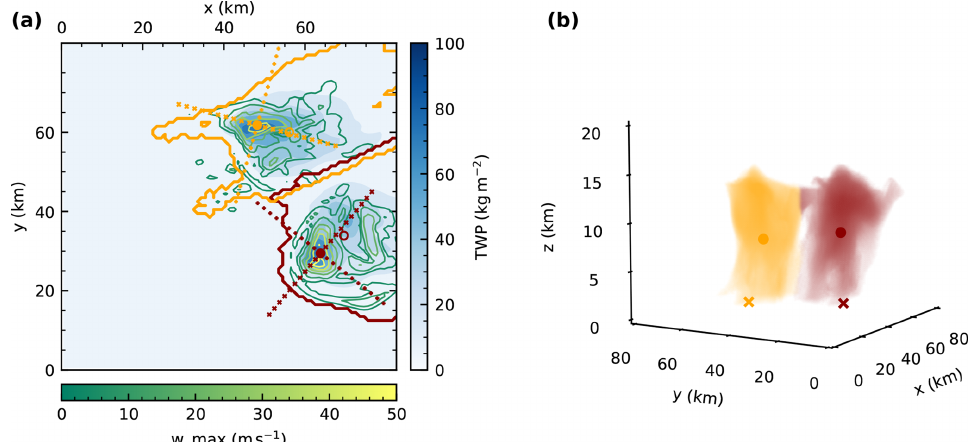
Figure 1. (a) Illustration of the result of the tracking and watershedding methodology after 90min of simulation time with the total water path field in blues and contours of column maximum vertical velocities in greens. The filled circles represent the tracked updraft cores, while the empty circles show the position of the centre of gravity determined by the watershedding algorithm. Crosses denote the slices along/across the line of travel of the cell that are used for the analysis of the cloud morphology. The coloured contour lines represent the projection of the respective cloud mask for each cell to the surface. (b) Three-dimensional rendering of the 1gkg − 1 condensate mixing ratio threshold of the two tracked cells in the simulation at the same point in time, including the horizontal location of the tracked updraft (cross) and centre of gravity